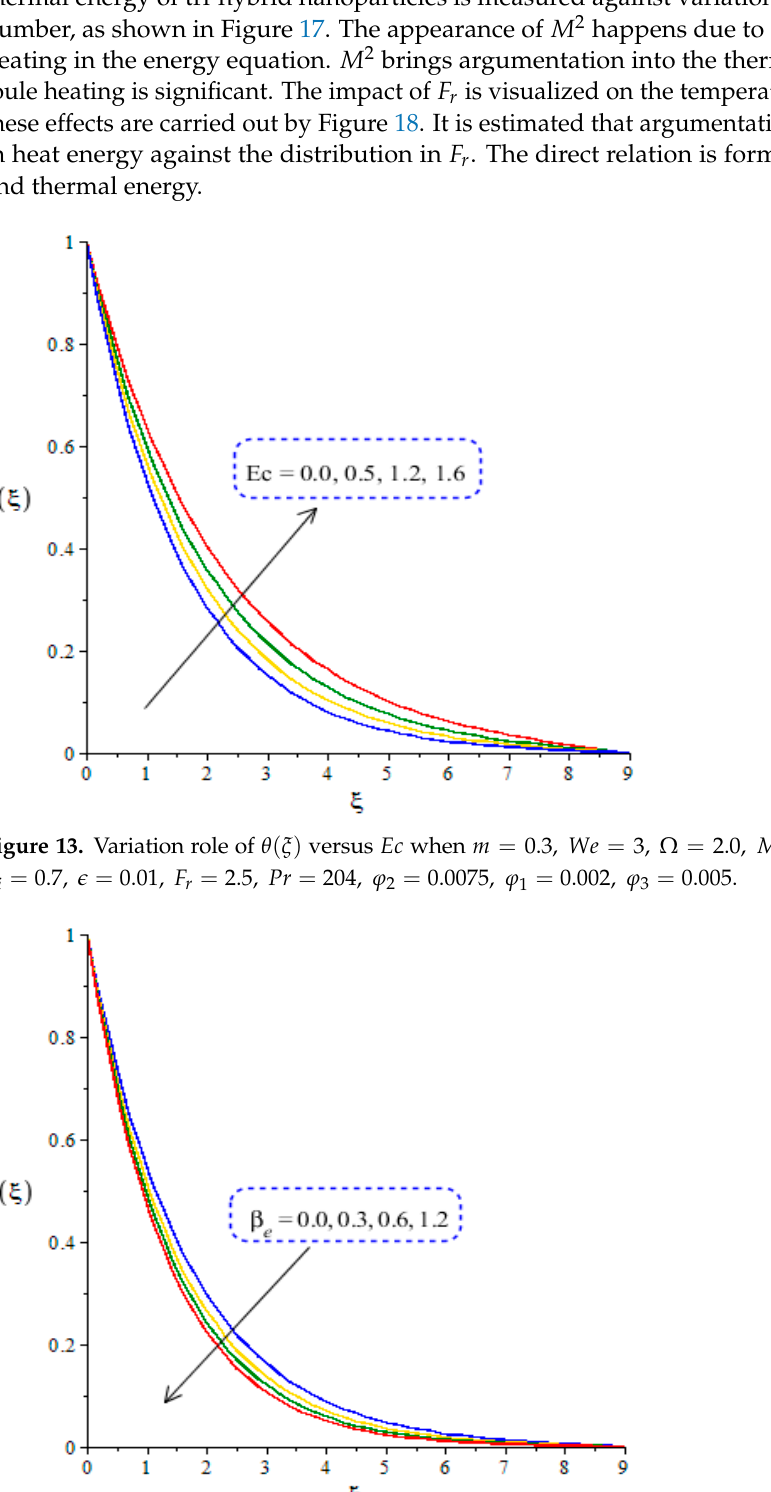
Figure 15. Variation role of 𝜃(𝜉) versus 𝛽 (cid:3036) when 𝑚 = 0.1,𝑊𝑒 = 3,Ω = 2.0,𝑀 (cid:2870) = 0.3, 𝛽 (cid:3032) = 0.5,𝜖 = 0.34, 𝐹 (cid:3045) = 2.0,𝑃𝑟 = 204,𝐸𝑐 = 0.3, 𝜑 (cid:2870) = 0.0075, 𝜑 (cid:2869) = 0.002, 𝜑 (cid:2871) = 0.005.